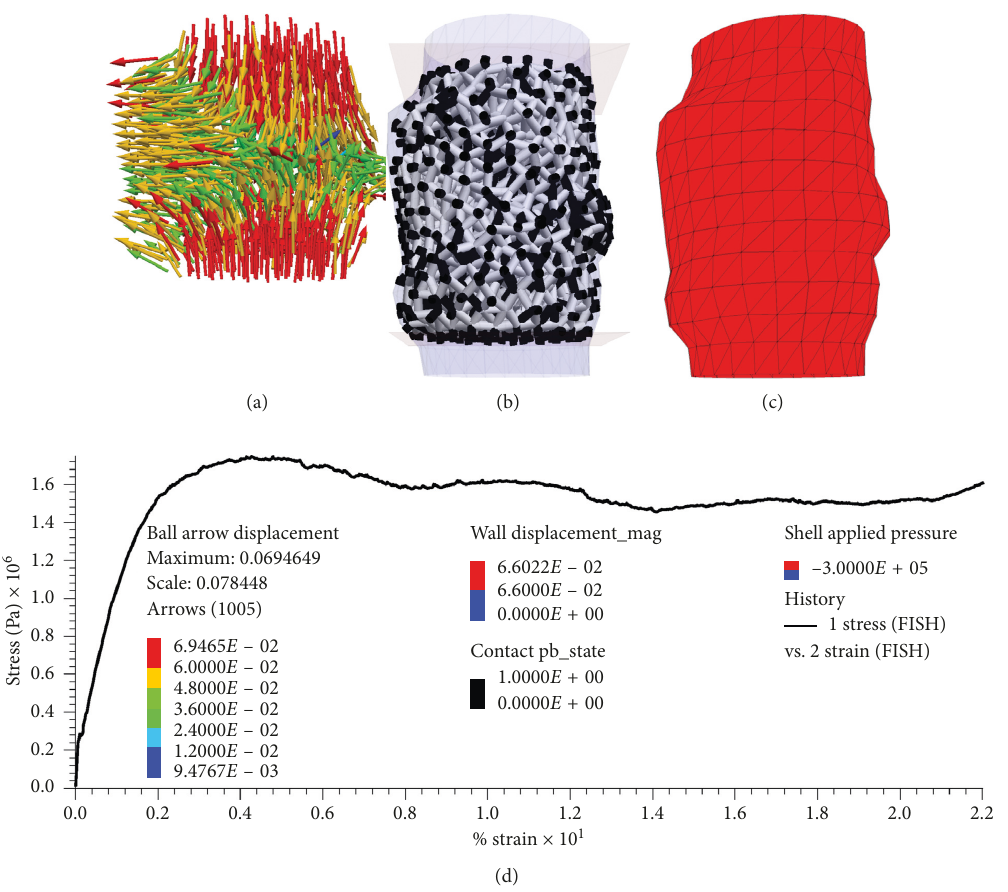
Figure 3: The three-axis numerical test of flexible servosystem under confining pressure of 300kPa sandy gravel.